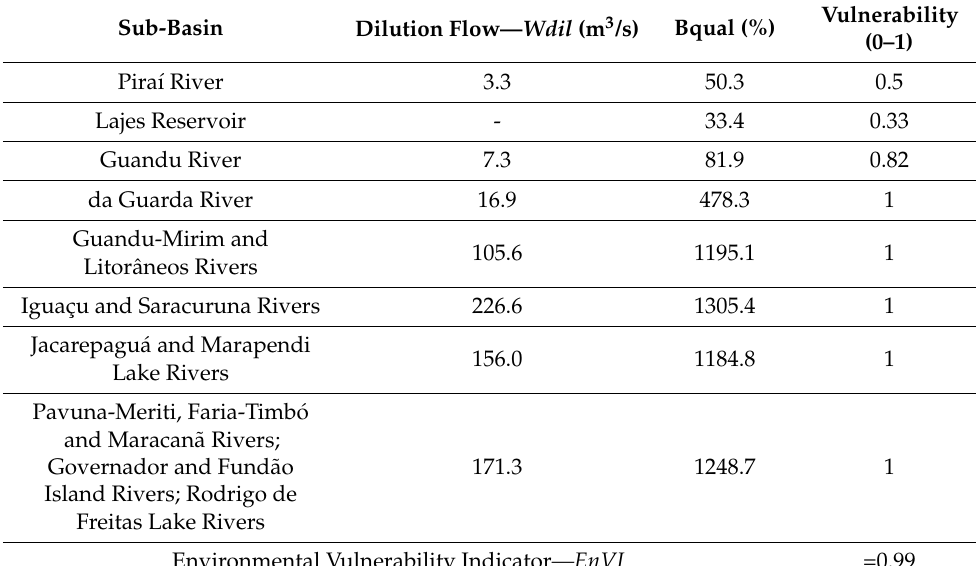
Table 14. Environmental vulnerability indicator ( EnVI ) application.